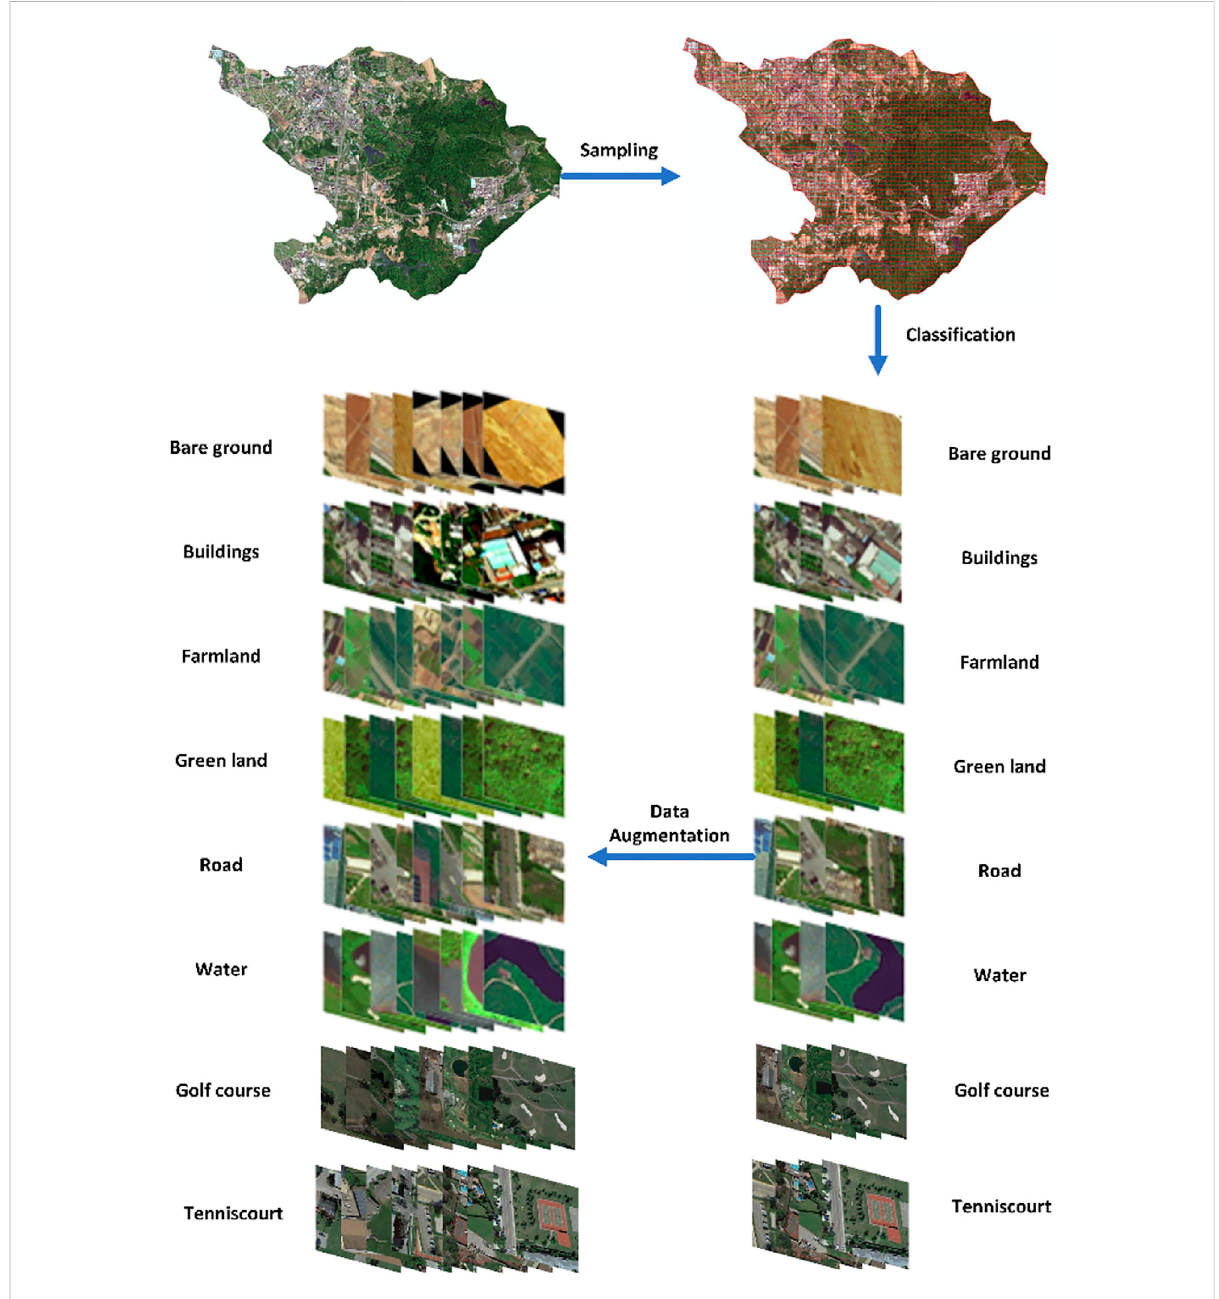
FIGURE 1 The dataset construction